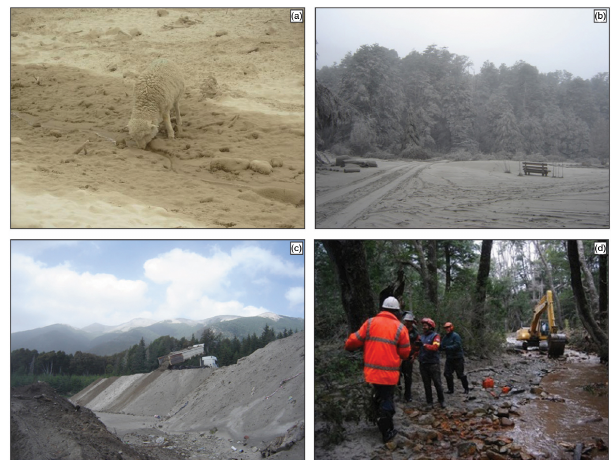
Figure 5. (a) Sheep covered with ash near Ingeniero Jacobacci (photo Diario de Río Negro, http://www.rionegro.com.ar/diario/); (b) Villa La Angostura Forest covered with tephra in June 2011; (c) over a million cubic metres of volcanic ash and lapilli were stocked in an old quarry; (d) army and fire management volun- teers cleaning the channels in order to mitigate lahars (photo http: